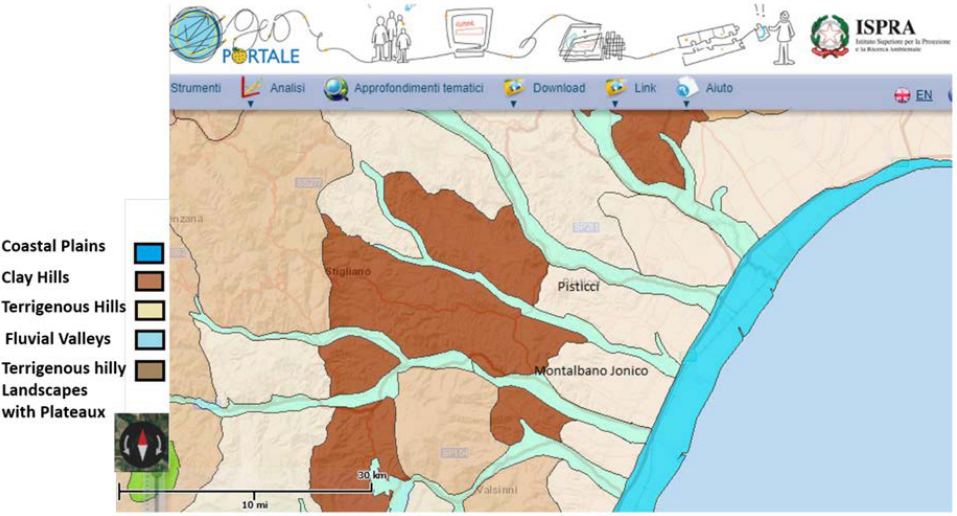
Figure 4. Landscape units of the case study, where are located the calanchive areas, between Montalbano Jonico and